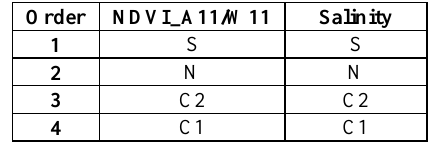
Table 10. Comparison between the rankings of AOIs in terms of NDVIs and salinity. The AOIs are reported in descending